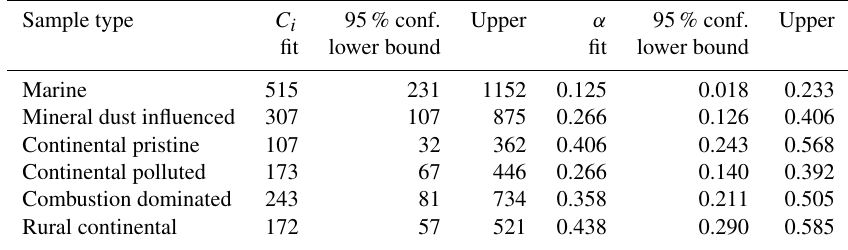
Table 4. Empirically fitted parameters for Eq. (4), ˆ τ ( t ) = C i t α , with 95% confidence bounds for the fitting parameters.